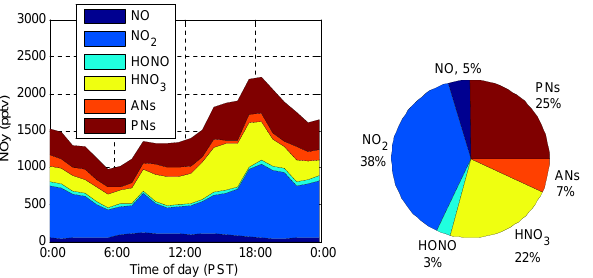
Fig. 8. Median diurnal variations (left) and distribution (right) of NO y species during BEARPEX2007. ANs represents total alkyl nitrates and PNs represents total peroxy nitrates. The pie chart is representative of a 24-h basis. Data collected between 15 August and 10 October, 2007 are used in this figure.